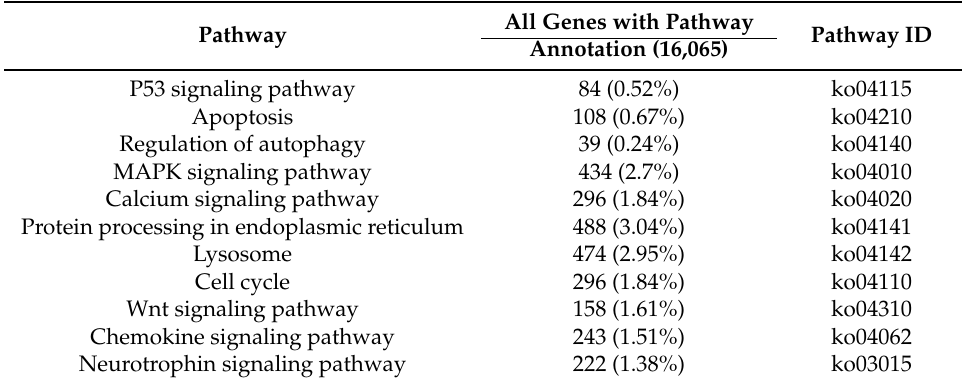
Table 3. Selected pathways are enriched and involved in the pathways of apoptosis, cell death and the cell cycle induced by the irradiation of P. citri